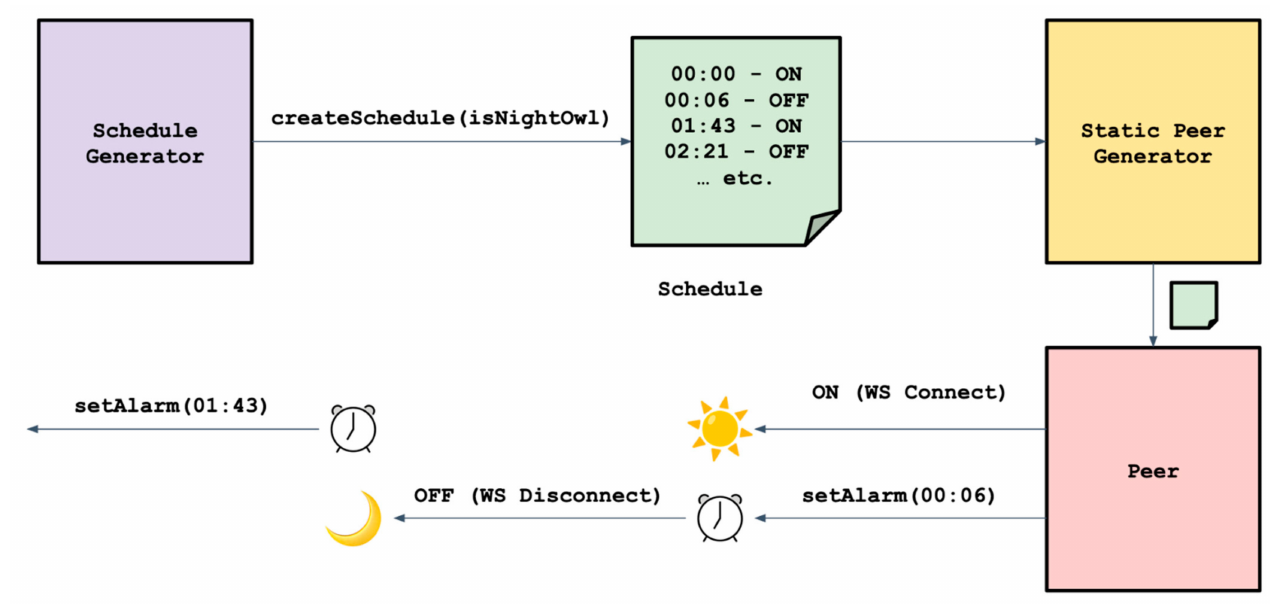
Figure 9. Peer Uptime Simulator generating schedules for